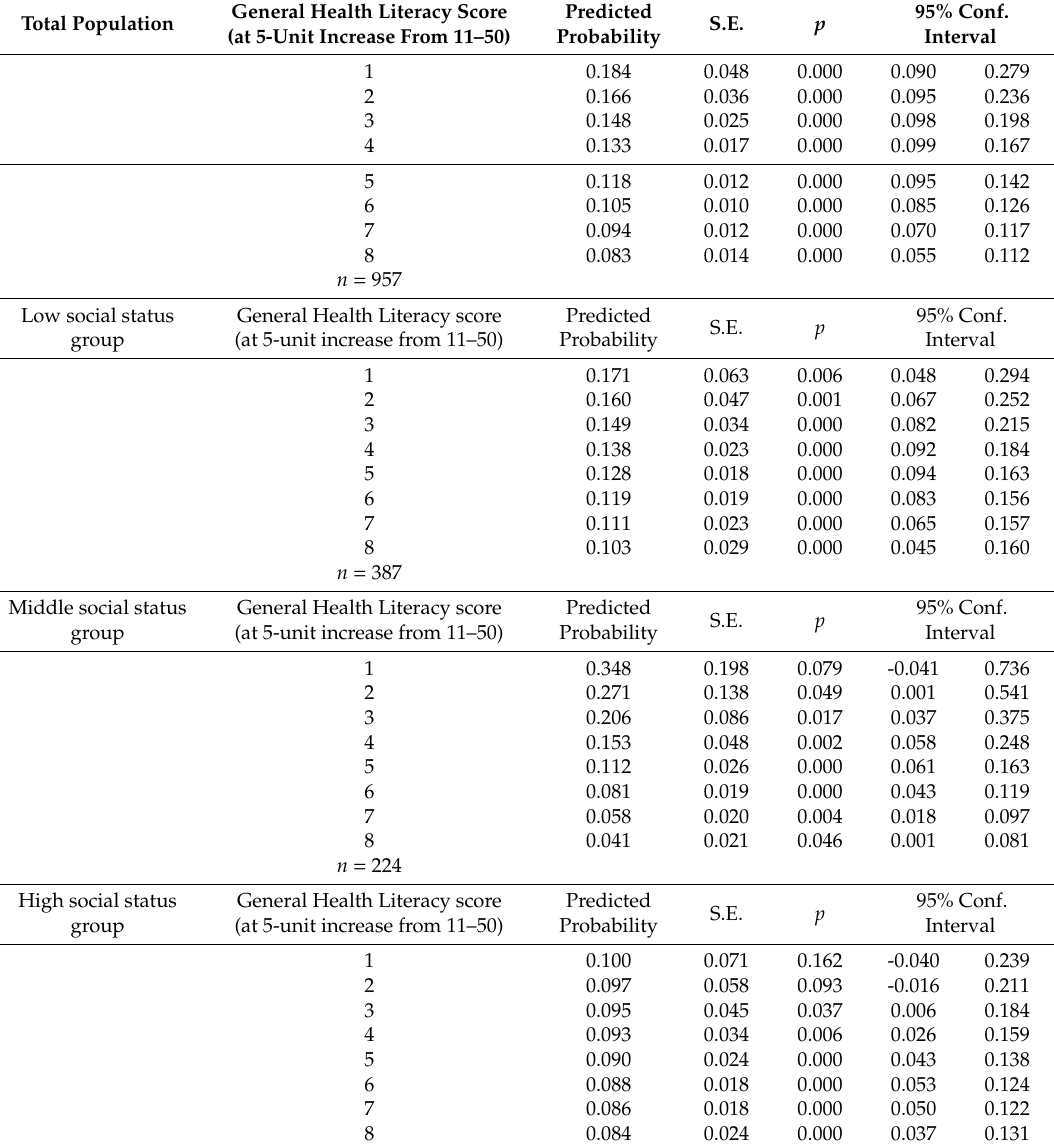
Table A5. Healthcare utilisation (3 + hospital visits in the past 12